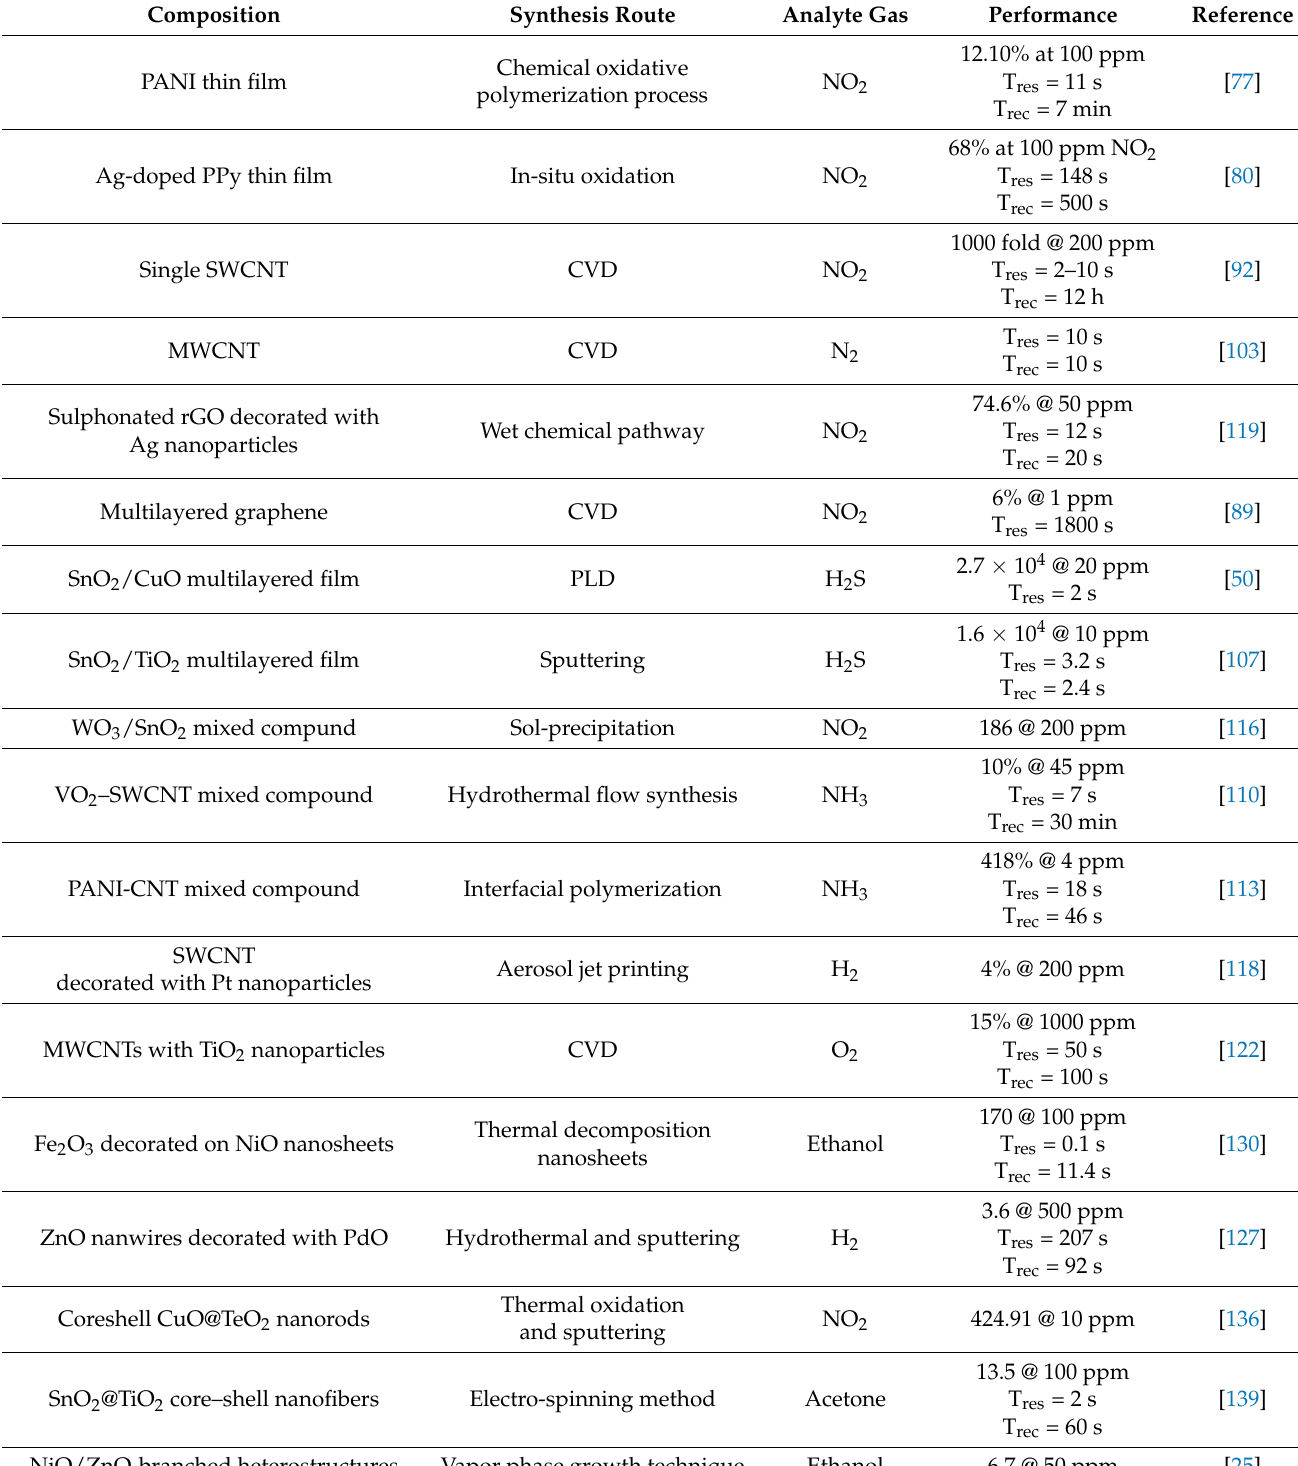
Table 2. Works reported and published in the past years for gas-sensor